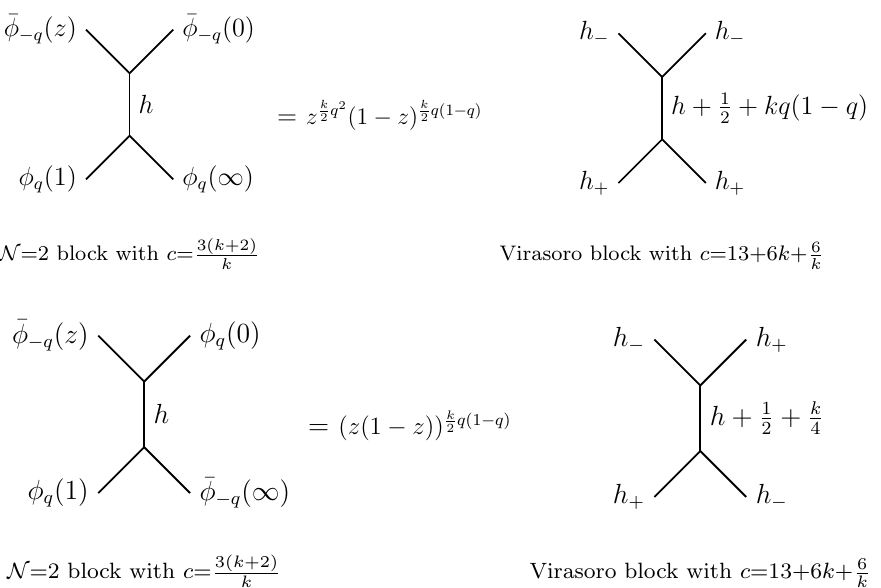
= 2 super-Virasoro blocks with external BPS primaries and bosonic N